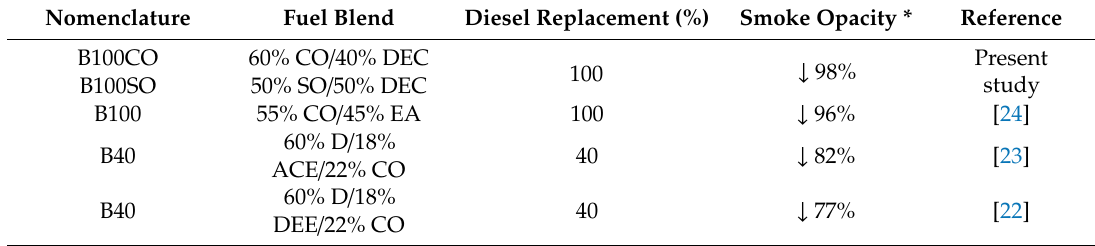
Table 6. Comparison between di ff erent fuel blends found in the literature and the blends analyzed here, in terms of smoke emissions and percentage of replaced